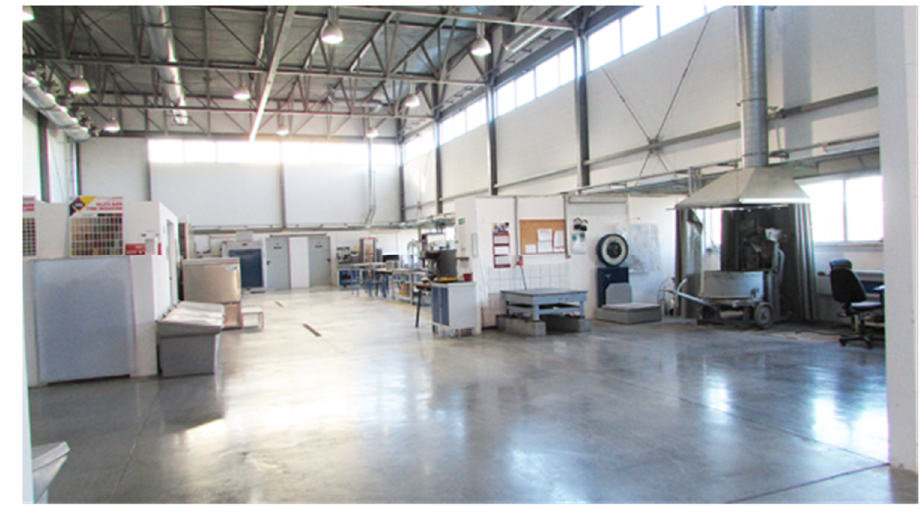
Figure 1. The tested industrial floor.